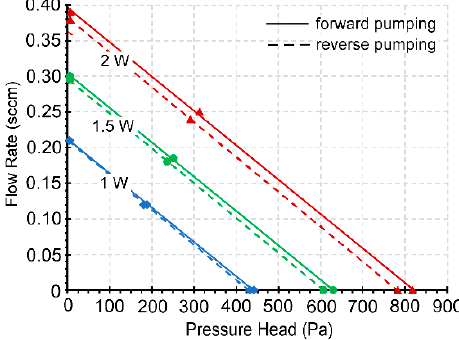
Figure 8. Steady-state performance of the 3D-KP.MCE showing the flow rate against the pressure head at three power levels. The forward and reverse pumping are almost identical.